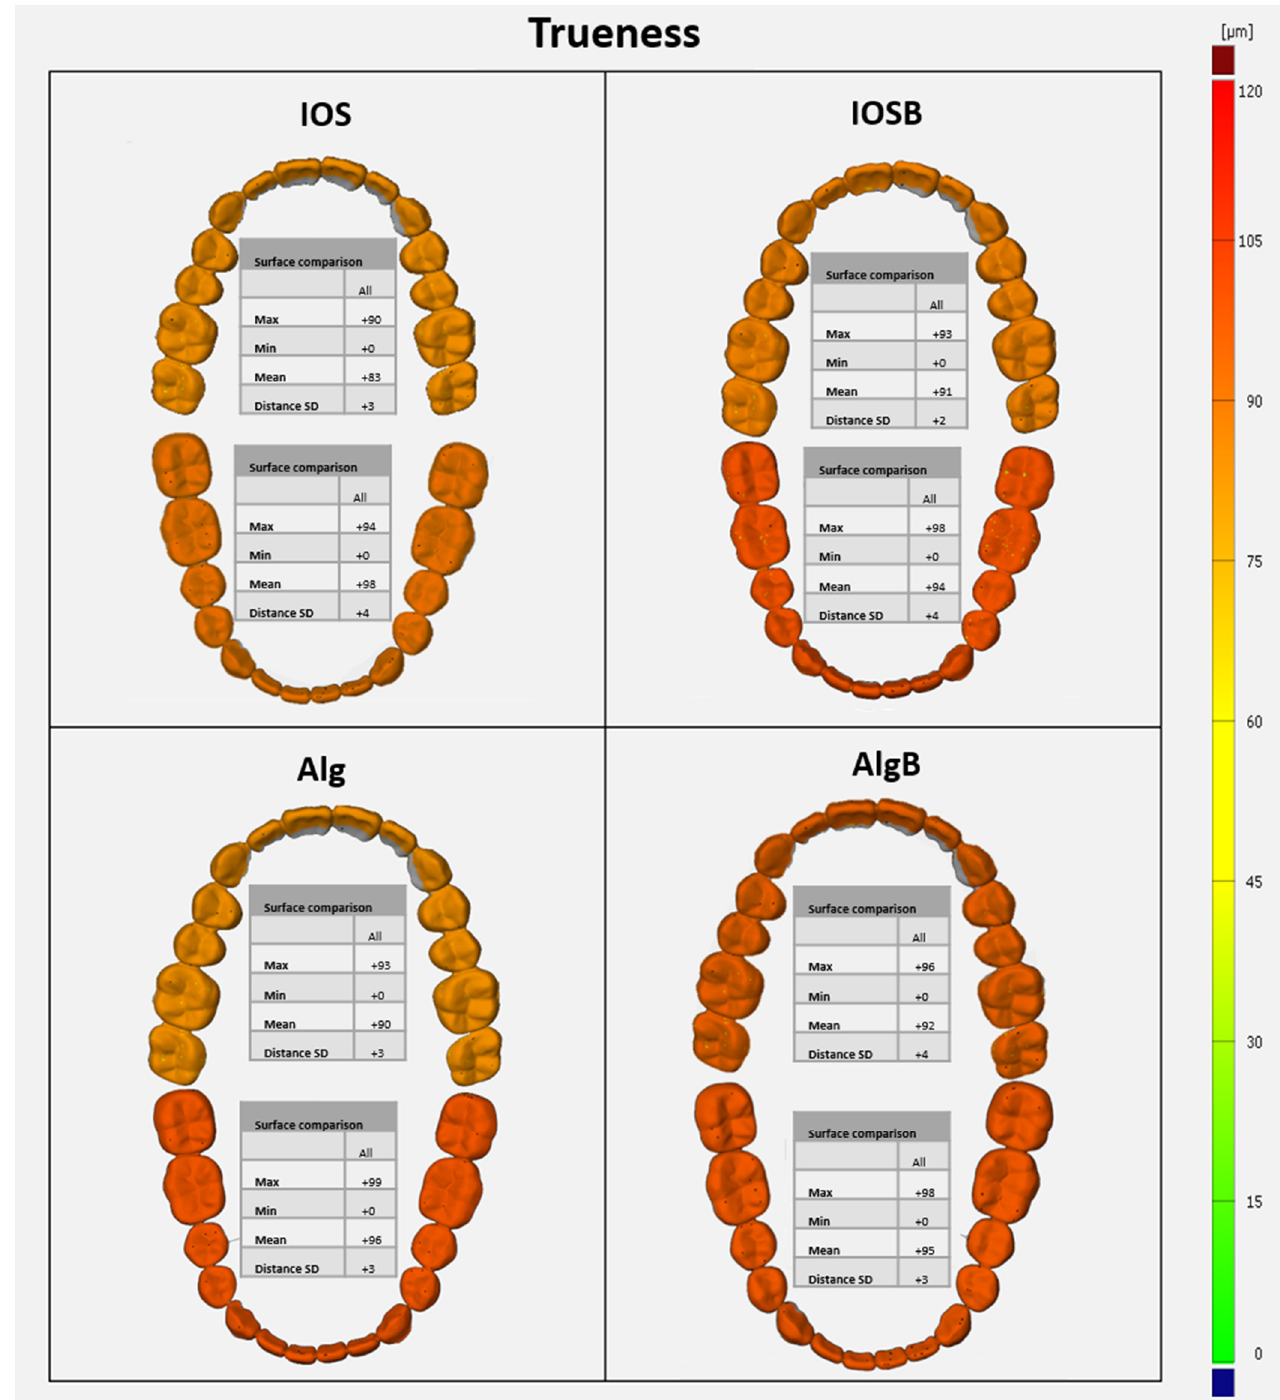
Figure 5. Color maps showing the trueness assessment measured through the alginate impression and TRIOS3 ® intraoral scanners.